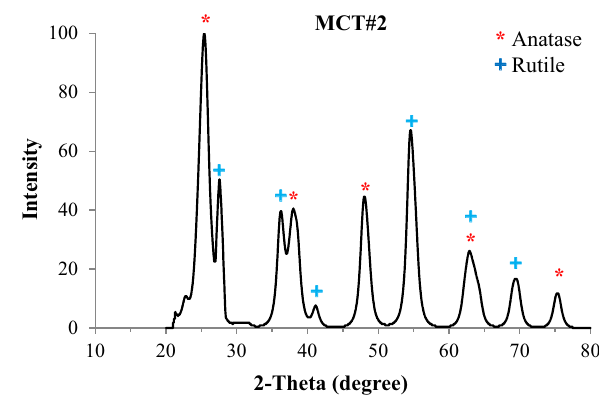
Fig. 2 XRD pattern of the synthesized